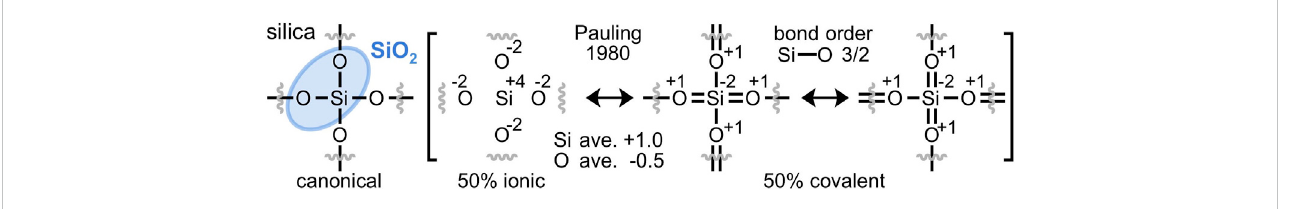
FIGURE 1 Pauling ’ s resonance hybrid model of α -quartz silica (SiO 2 ) is 50% ionic and 50% covalent. Silicon-oxygen double bonds formally reduce silicon and oxidizeoxygen,yieldingaveragedSi +1 andO − 0.5 atomicchargesandSi-Obondordersof3/2(Pauling,1980).Thisresonancemodeliscontradictedbymodern computational investigations that discount silicon-oxygen double bonds in